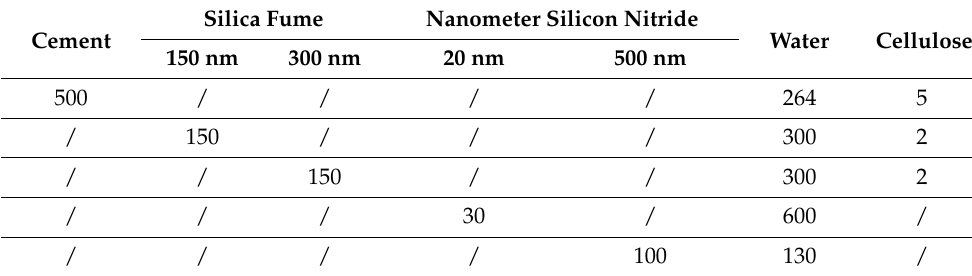
Table 8. The mix proportion of the different slurry (kg/m 3